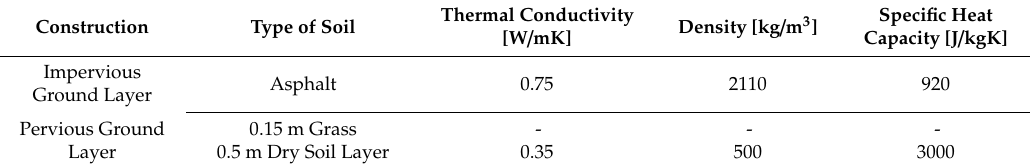
Table 2. Overview of considered ground layers and soil materials (source: [22]).